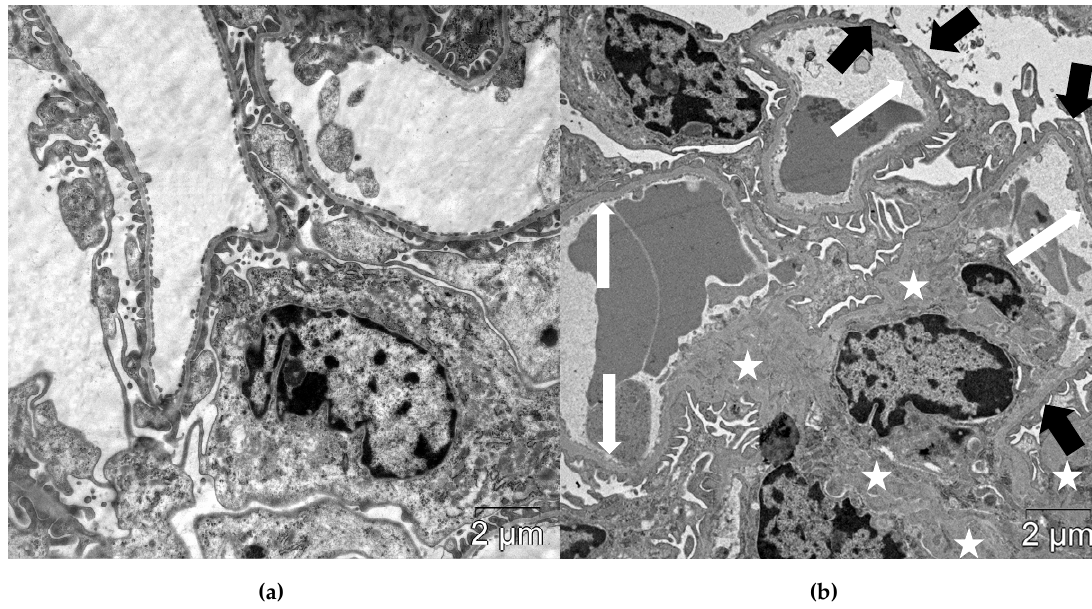
Figure 2. Glomerular structure in non-diabetic db/+ mice (a) and vehicle-treated diabetic db/db mice (b). Diabetic mice demonstrated thickening of GBM (white arrows), effacement of podocyte FPs (black arrows) and mesangial expansion (white stars). Scale bar 2 µm. TEM. Table 4. Glomerular structural parameters in db/+ and db/db mice.